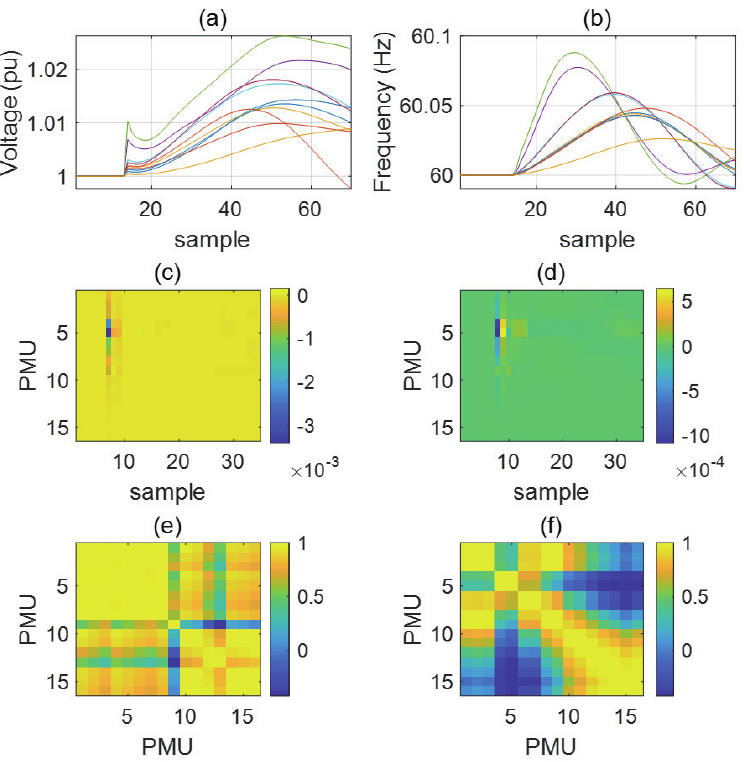
Figure 3. Typical preprocessed feature data: ( a , b ) are original signals, ( c , d ) are PMU via time domain data, ( e , f ) are PMU via PMU domain data for voltage and frequency,